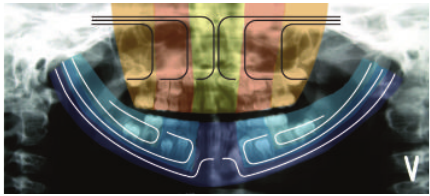
Figure1:Theembryologicaldevelopmentofthejawsandteethfrom the neural crest, shown schematically in colours on a panoramic radiograph. The different fields in the mandible are marked in blue. The white lines show three different courses of peripheral nerves to the teeth and bone in the mandible. In the maxilla, the bilateral frontonasal fields are marked in yellow, the bilateral maxillary fields in red, and the bimaxillary palatinal fields in orange. The black lines show three different courses of peripheral nerves to the teeth and bone in the maxilla.